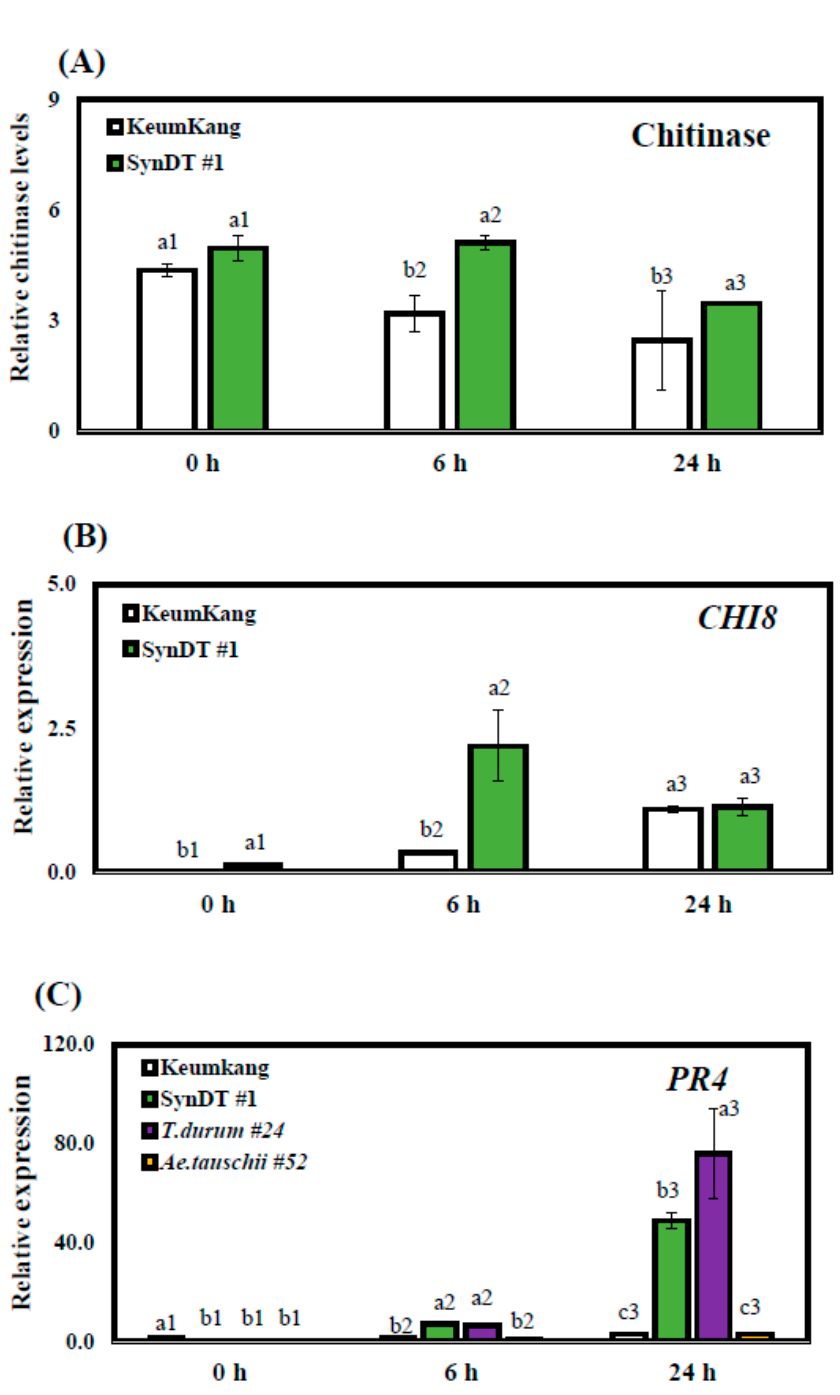
Figure 6. Chitinase levels in response to LR infection. ( A ) The chitinase levels of Keumkang and SynDT #1 in response to LR at 0, 6, and 24 hpi. ( B ) The transcript levels of CHI8 , chitinase-encoding enzymes in Keumkang and SynDT #1, in response to LR at 0, 6, and 24 hpi. ( C ) The relative expression levels of PR4 of Keumkang, SynDT #1, T. durum #24 , and Ae. tauschii #52 in response to LR at 0, 6, and 24 hpi. Eight-day-old seedlings were exposed to LR. The samples were collected after 0, 6, and 24 hpi for enzymatic assay or to measure the transcript levels. The experiments were conducted at least twice to verify that the results were consistent. Standard deviation value was calculated from three replicates in each treatment. One-way ANOVA and Tukey’s test ( α = 0.05) were performed using SAS. Different letters (a, b, or c) indicate significant differences ( p < 0.05).